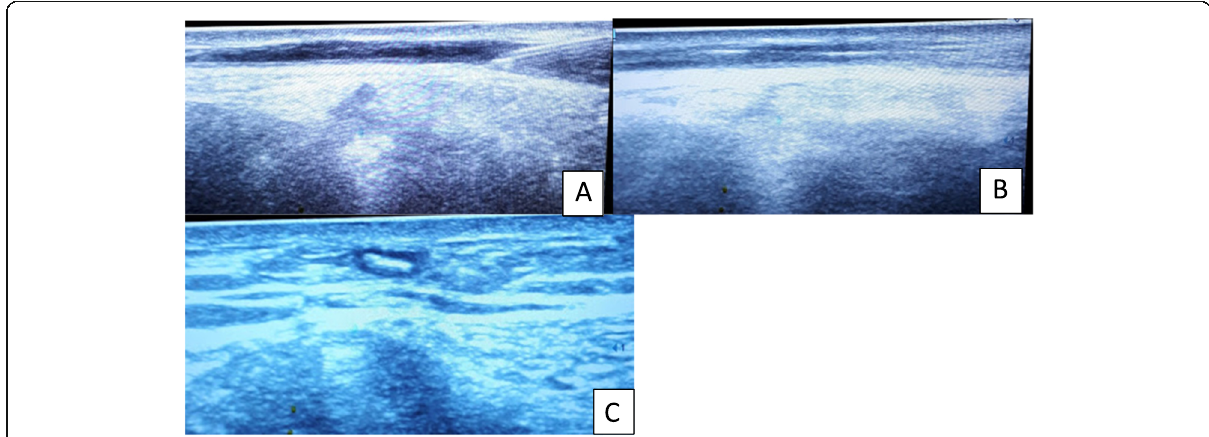
Fig. 3 Superficial varicosities injected with 2% Pol. with USGFS. a Needle within the vein. b The acoustic shadowing while injecting the foam. c Transverse view of the vein showing air within the lumen